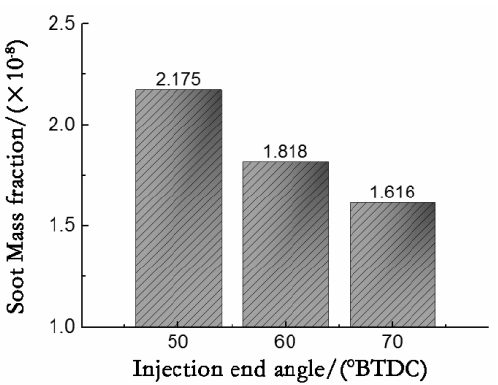
Figure 20. Soot data corresponding to different injection end angles.